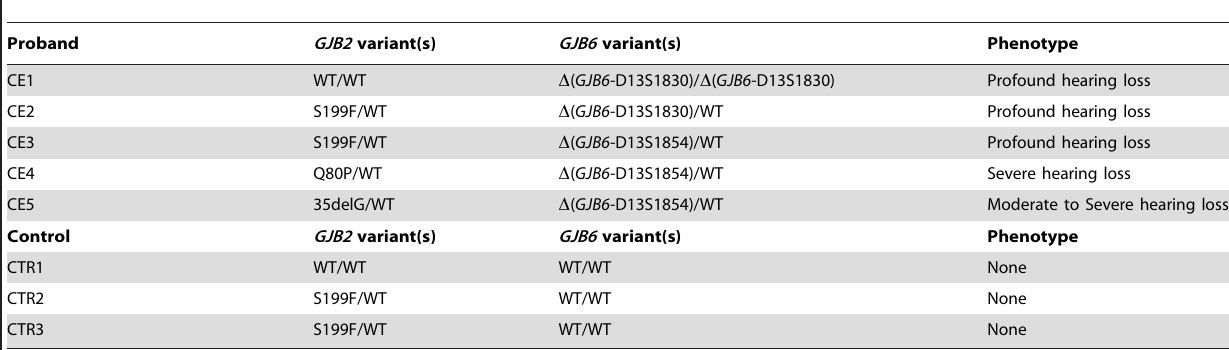
Table 1. Genotypes and phenotypes of study